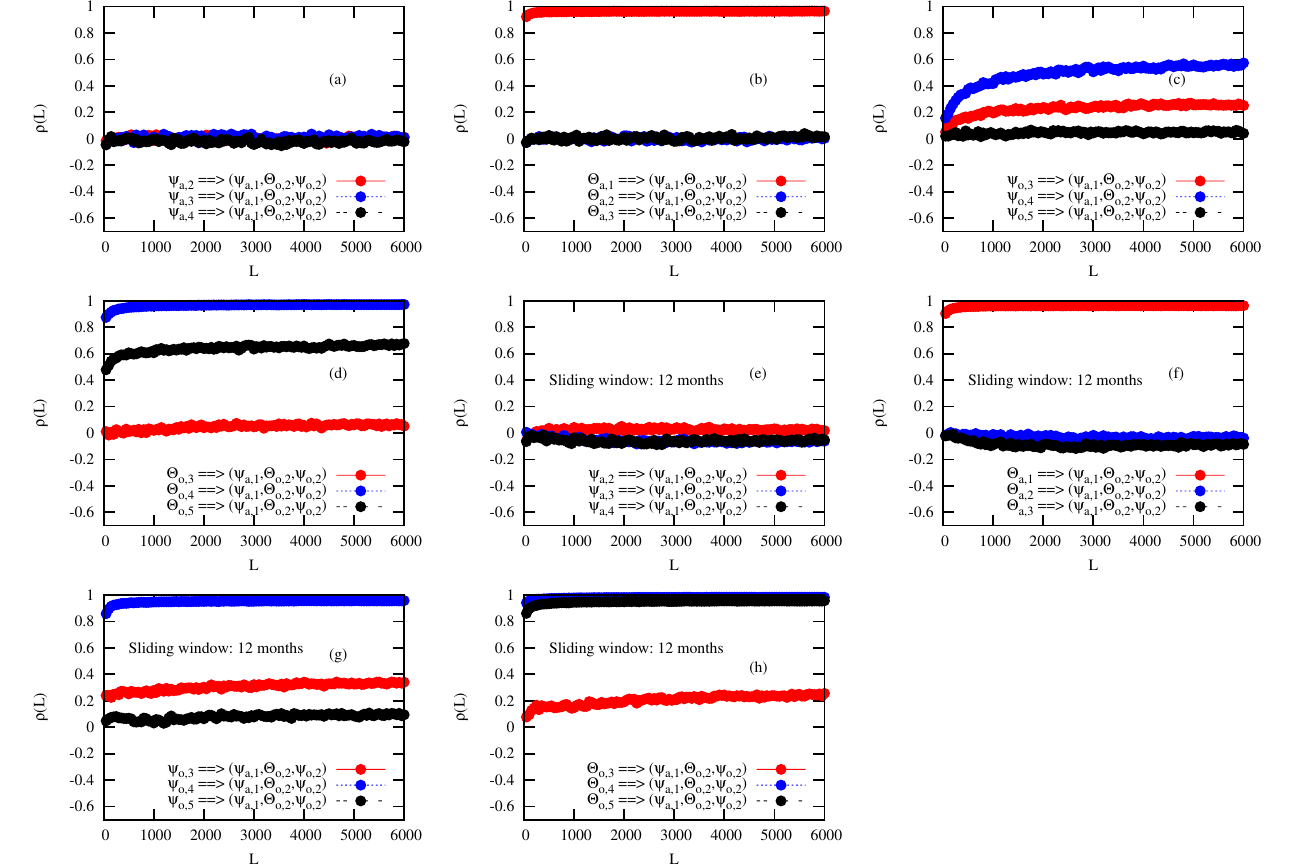
Figure B1. CCM as a function of the length L of the samples, as obtained from monthly time series of the low-order coupled ocean– atmosphere model integration. Panels (a) to (d) display the values for the influence of a set of model variables on ( (cid:57) a , 1 ,(cid:50) o , 2 ,(cid:57) o , 2 ) at a monthly timescale. Panels (e) to (h) display the values for the influence of a set of model variables on ( (cid:57) a , 1 ,(cid:50) o , 2 ,(cid:57) o , 2 ) after the application of a sliding average over 12 months. Each line with symbols corresponds to the influence of one variable on ( (cid:57) a , 1 ,(cid:50) o , 2 ,(cid:57) o , 2 ). The specific variables are denoted in the caption corresponding to each line in each